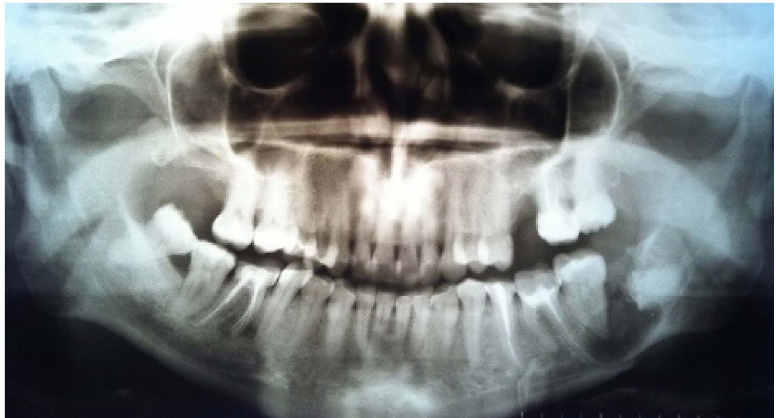
Figure 1. Orthopantomogram before surgery.